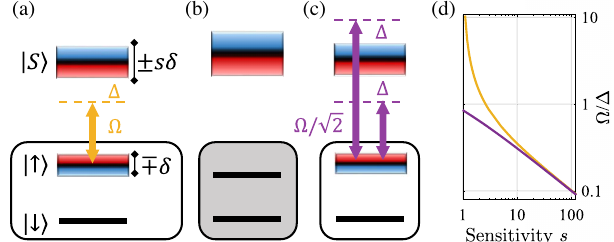
FIG. 1. Continuous protection of a quantum state. (a) Transition frequency of the qubit j ↓ i − j ↑ i , without protection, shifted by δ due to some source of inhomogeneity, and an auxiliary sensor state j S i , which experiences an opposite and possibly larger shift, − s δ . A single field with Rabi frequency Ω and detuning Δ dresses the qubit with the sensor state. (b) Protected qubit formed under conditions of optimal dressing. The transition frequency of the protected qubit is slightly altered by the mean light shift. (c) Two dressing fields of equal intensities and opposite detunings, applied to further eliminate the mean shift and reduce the sensitivity of the protected qubit to dressing noise. (d) Optimal dressing ratio Ω = Δ as a function of the sensitivity parameter s for the single-dressing (orange) and double-dressing (purple)